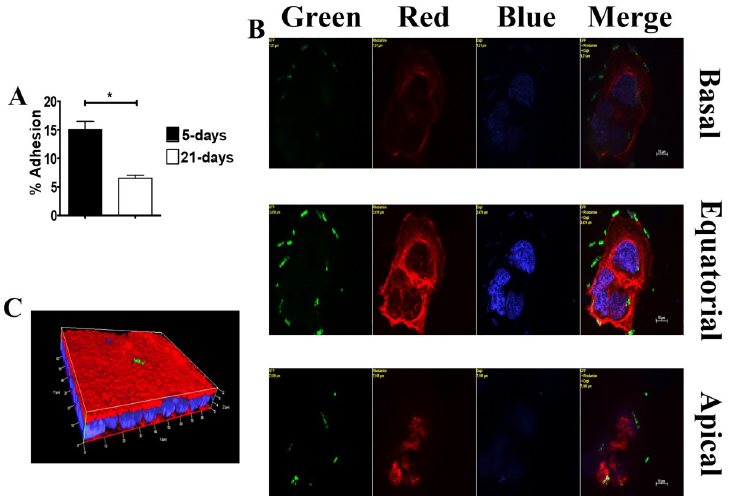
Fig 1. GBS adherence to Caco-2 cells. GBS adherence in infected islands and monolayers of Caco-2 cells. ( A) GBS adherence as measured by CFU counting in 5-day-old islets and 21-day-old monolayers. Shown are means ± SD of three independent experiments conducted in triplicate. � , p < 0.05 by Mann-Whitney test. ( B ) GBS adherence to the outer edges of 5-day-old small islets. Yellow labels indicate the filter(s) used and the distance, in μ m, of the optical section from the slide plane. ( C ) GBS adherence to a small area of the brush border in 21-day-old monolayers (three- dimensional reconstruction). Nuclei and actin filaments were labeled with DAPI (Blue) and Phalloidin-iFluor 555 (Red), respectively. Bacteria (Green) were labeled using a rabbit anti-GBS serum followed by Alexa Fluor 488-conjugated anti-rabbit IgG. Scale bar = 10 μ m.